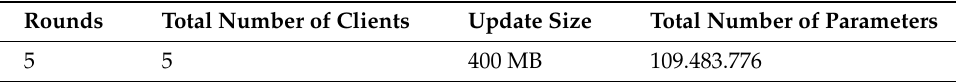
Table 2. Federated training configuration.